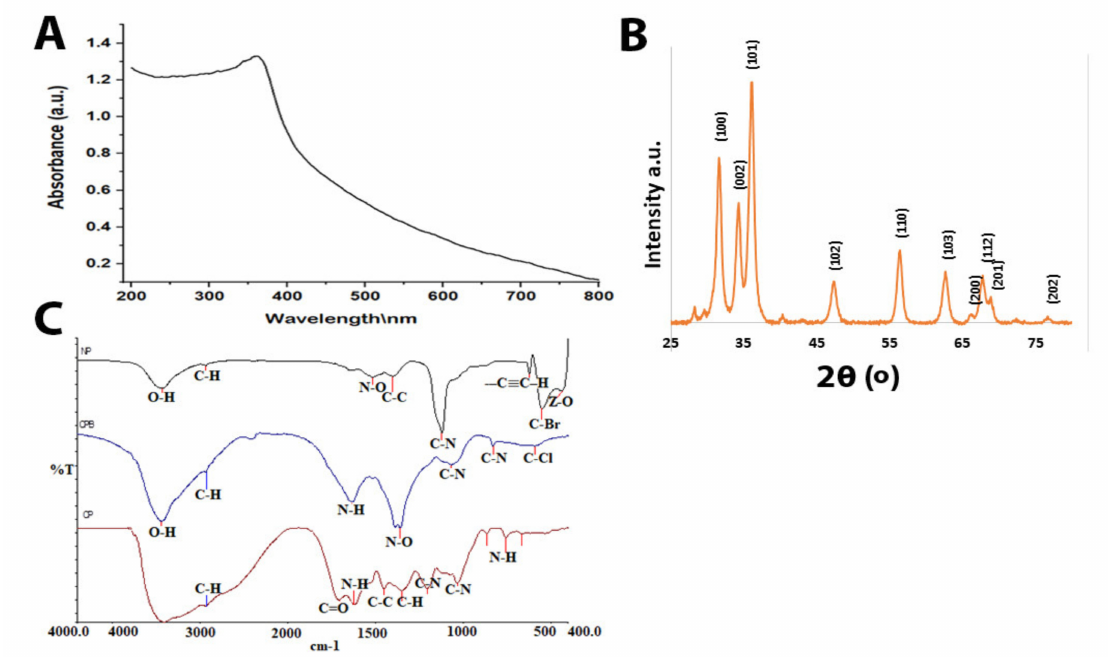
Figure 1. ( A ) UV–visible spectrum of ZnO-NPs. ( B ) XRD of ZnO-NPs. ( C ) FTIR of ZnO-NPs (NP = the formed ZnO-NPs after calcination, CFB = ZnO-NPs before calcination and CP = the aqueous extract of Acacia nilotica